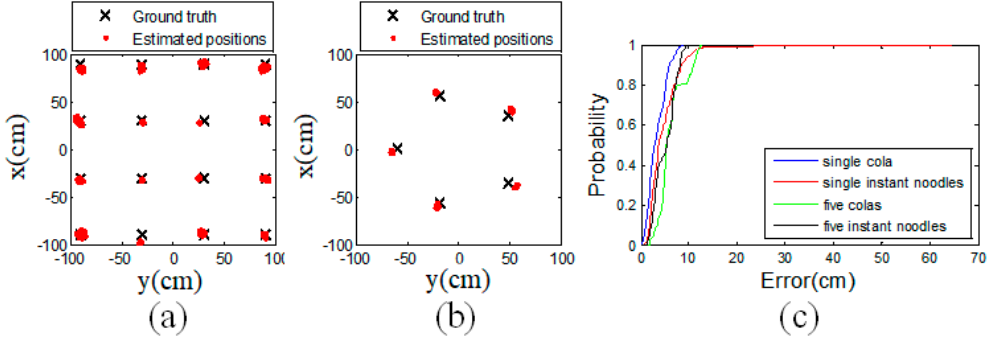
Figure 9. The localization results: ( a ) single target localization results of 16 test positions, ( b ) five-target localization results, and ( c ) CDFs of 2-D localization.